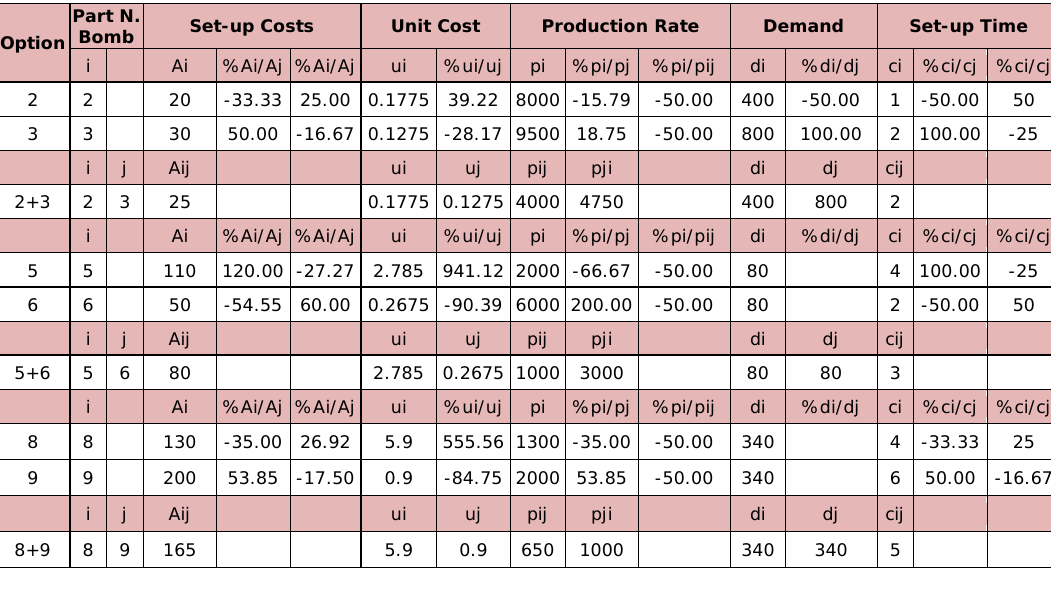
Table 4. “Analysis of coproduction